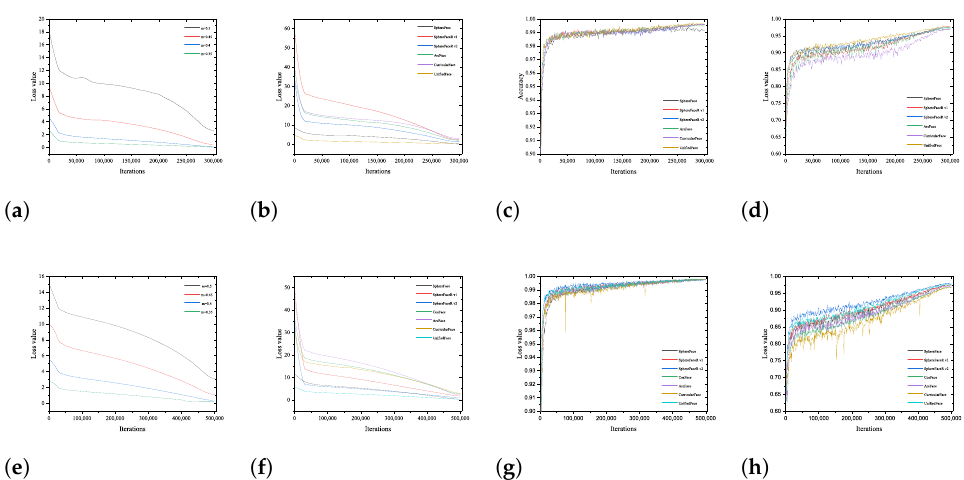
Figure 7. ( a , e ) denotethe change in loss values of UnifiedFace using different training datasets with various hyperparameters, respectively. ( b , f ) indicate the comparison of loss values of UnifiedFace using different datasets with state-of-the-art methods. ( c , g ) represent the comparison of UnifiedFace using various datasets with state-of-the-art methods in the LFW validation dataset. ( d , h ) show the comparison of UnifiedFace using different datasets compared with popular methods in the CFPFP validation dataset.